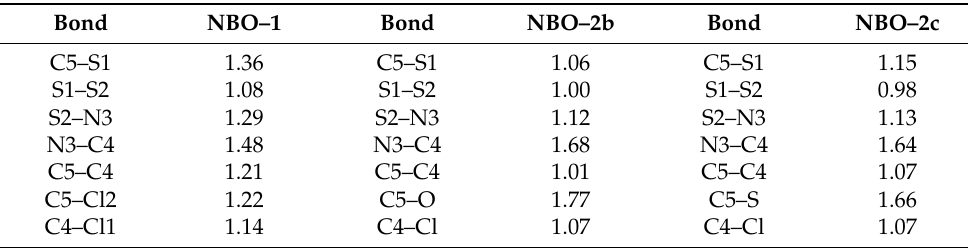
Table 7. NBO bond orders calculated at the B3LYP/def2-TZVPD level of theory for Appel’s salt 1